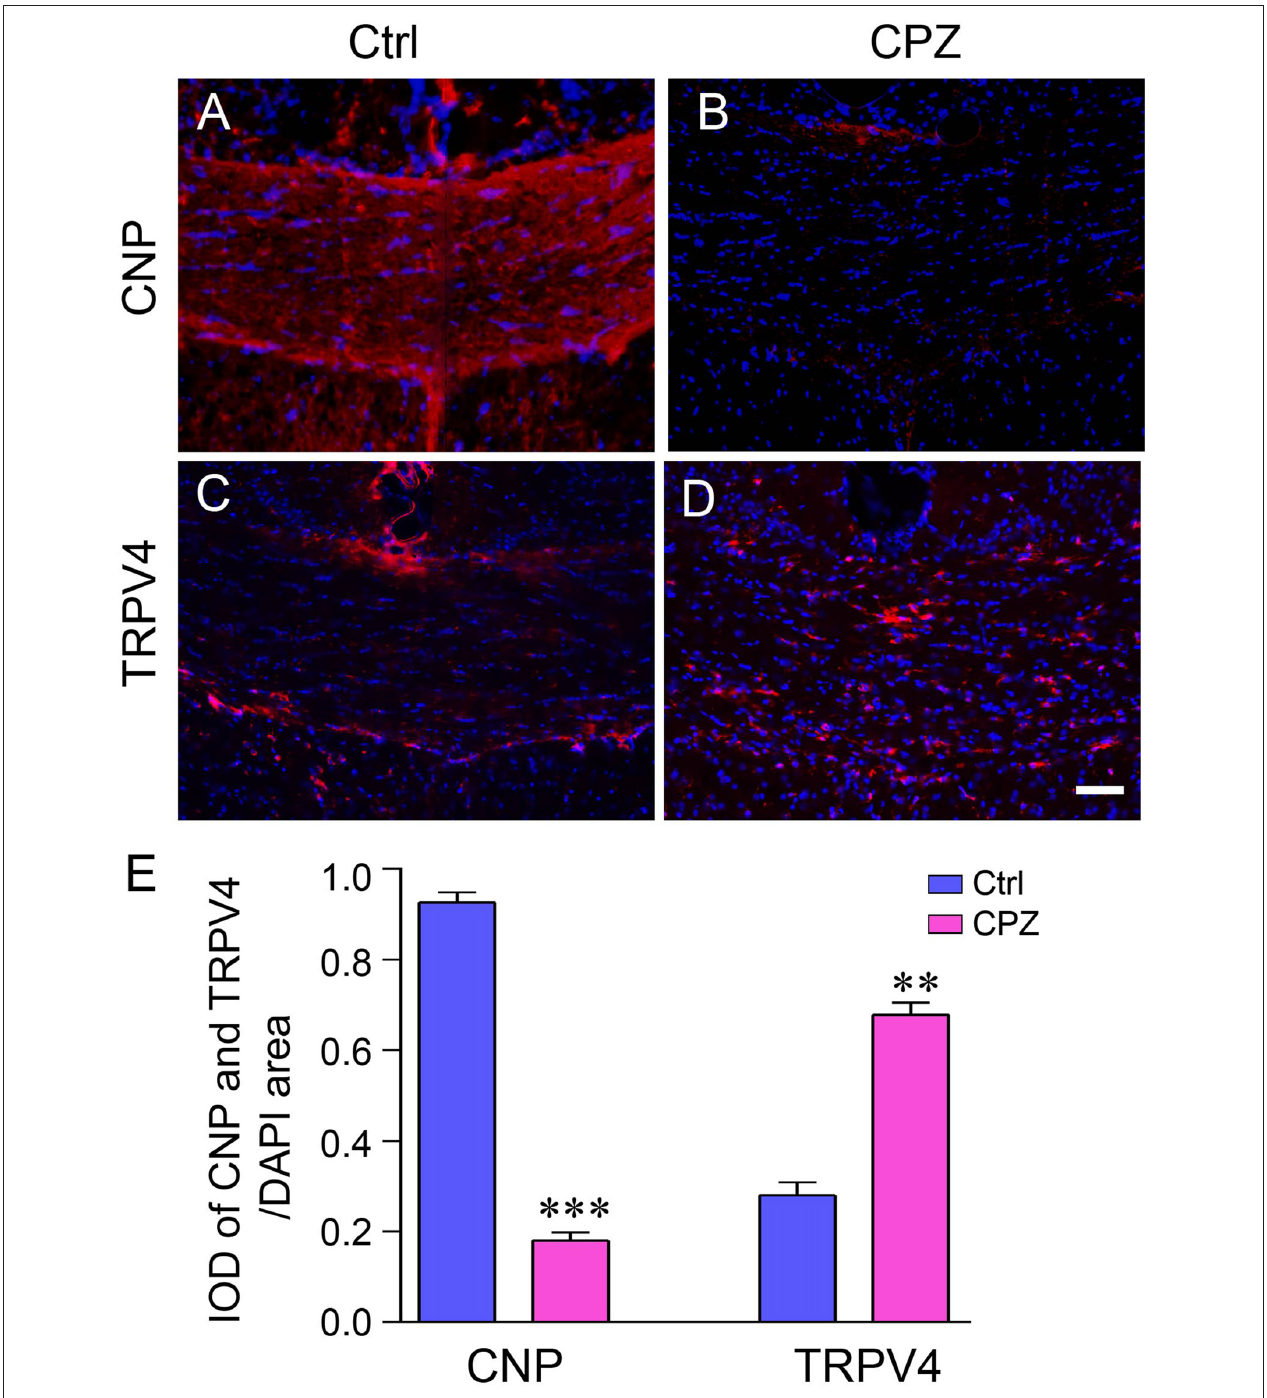
FIGURE 1 | The expression of transient receptor potential vanilloid 4 (TRPV4) was increased in the cuprizone (CPZ)-treated mice. Immunofluorescence staining of 2 (cid:48) ,3 (cid:48) -cyclic nucleotide 3 (cid:48) phosphodiesterase antibody (CNP) (A,B) and TRPV4 (C,D) in the corpus callosum of the control (Ctrl) group and the CPZ group. Scale bar = 20 µ m. (E) Integrated optical density (IOD) analysis of CNP- and TRPV4-positive cells. n = 4 per group. The data are shown as the mean ± SEM. ∗∗ P < 0.01, ∗∗∗ P < 0.001 vs. the Ctrl group.